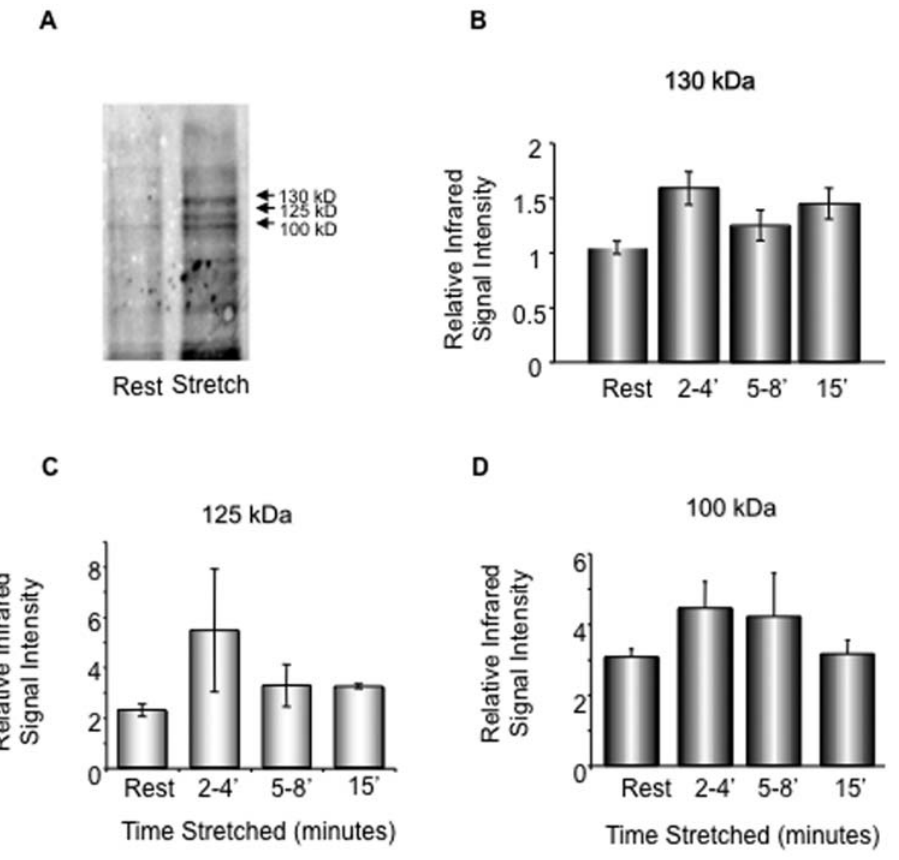
Figure 4. Stretch-induced tyrosine phosphorylation in human myometrium. A. A typical anti-phosphotyrosine immunoblot. Term pregnant uterine smooth muscle strips unstretched or stretched to 2x slack length for 2 min. The tissue homogenates were immunoblotted with an anti- tyrosine phosphorylation antibody. B–D. Term pregnant uterine smooth muscle strips were unstretched (rest) or stretched to 2x slack length at indicated time period. Average densitometry of phospho-tyrosine bands of 130 kD, 125 kD and 100 kD. n=3–5 samples in each